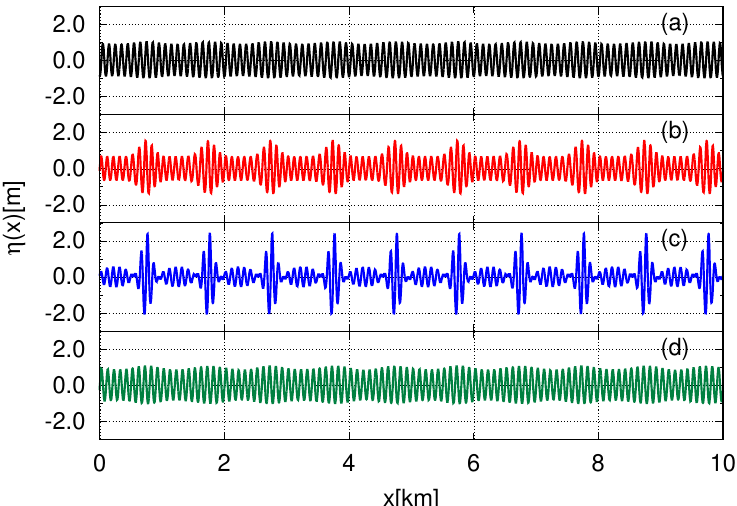
Figure 6. Simulations in the framework of the NLS model at large times. Different panels show snapshots of the free surface at: ( a ) t ≈ 47 h ( b ) t ≈ 47.4 h ( c ) t ≈ 47.6 h and ( d ) t ≈ 48.2